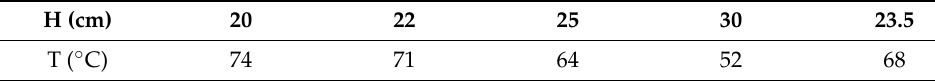
Table 6. Infrared lamp height and specimen surface temperature.